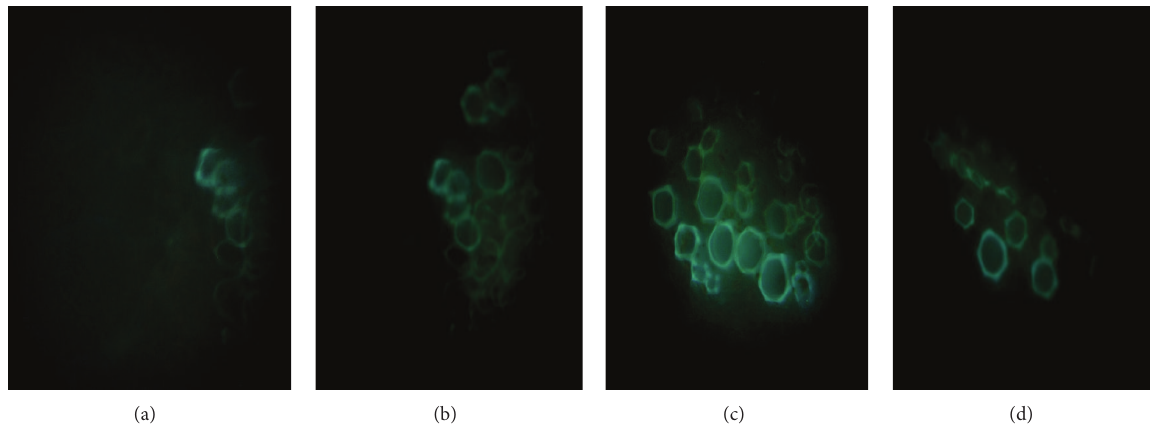
Figure 2: Nitric oxide visualization in the leaf petiole sections of tomato by DAF-2DA stain, 24 h after CuCl 2 treatment. Generation of NO was detected by green fluorescence. (a) Control; (b) treatment with 1mM CuCl 2 ; (c) treatment with 2.5 mM CuCl 2 ; and (d) treatment with 5 mM CuCl 2 .